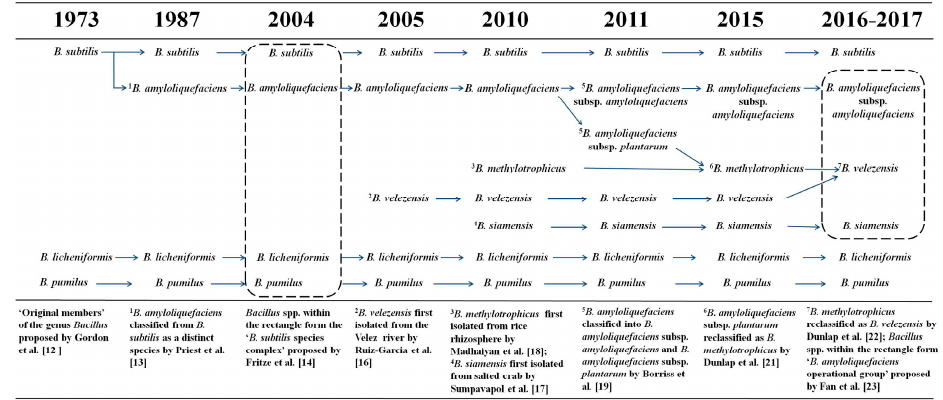
Figure 1. Bacillus velezensis is the conspecific species integrating B. amyloliquefaciens subsp. plantarum and B. methylotrophicus (adapted by Dunlap et al. [22]). The significance of the numbers are explained at the bottom of the same column.